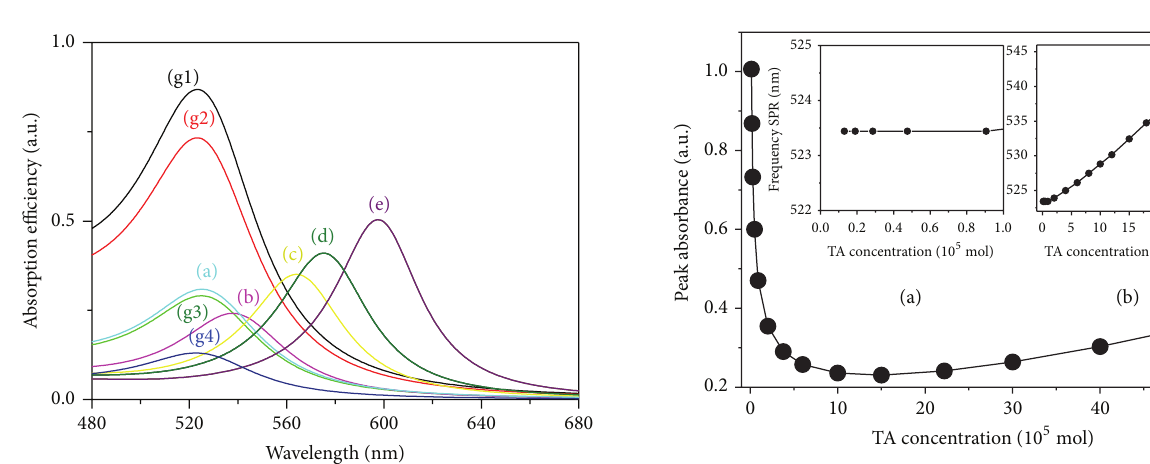
Figure 5: Absorbance efficiency (Mie theory) at different TA concentrations (10 5 mol): g1 (0.029), g2 (0.059), g3 (0.59), g4 (4.1), a (22.2), b (50.0), c (60.0), d (80.0), and e (90.0).